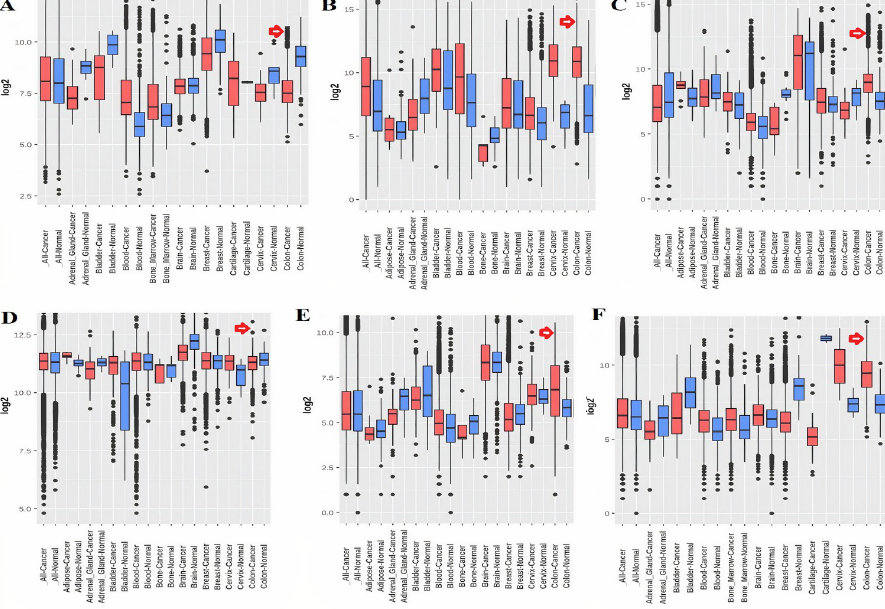
Fig 4. Box plots showing the relative expression levels of real hub genes in normal and COAD patients (Information retrieved from GENT2 database). The box plots shows the relative mRNA expression of: (A) CXCL12, (B) CXCL8, (C) AGT, (D) GNB1, (E) GNG4, and (F) CXCL1; in COAD patients and normal samples. A p-value of < 0.05 was considered